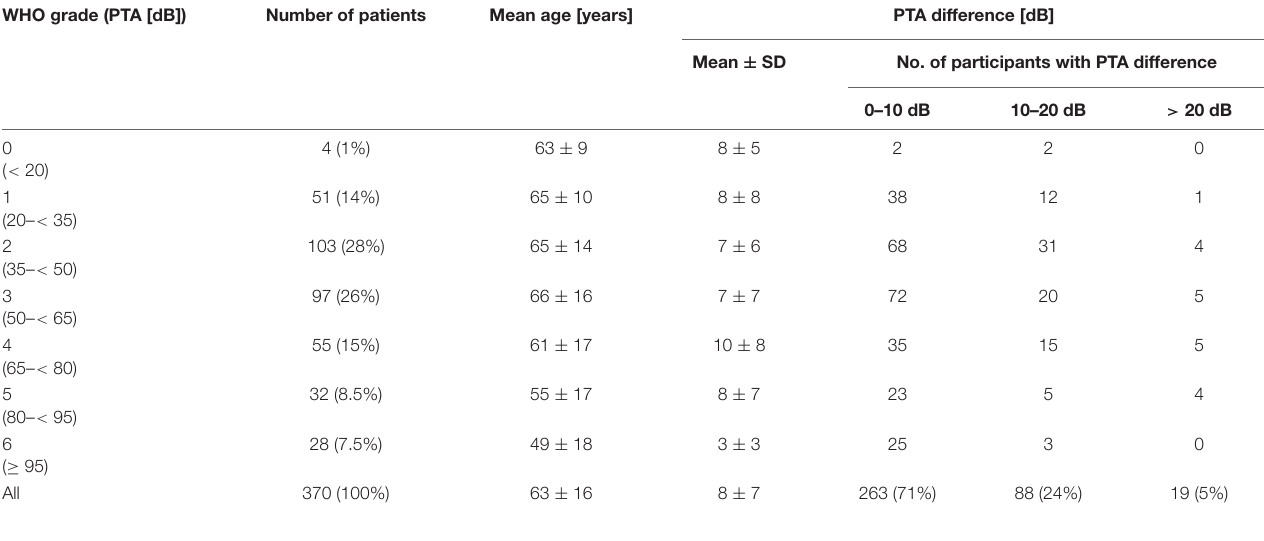
TABLE 1 | Patient